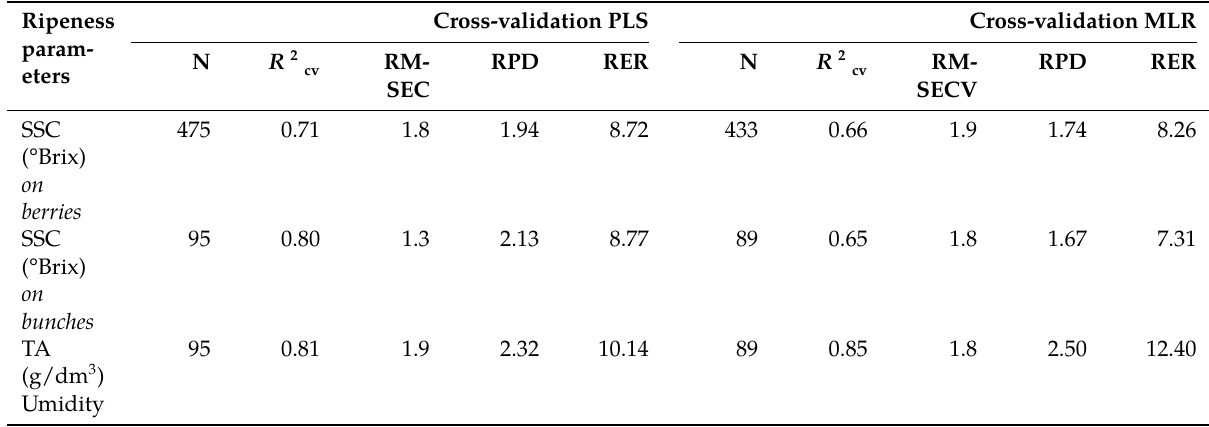
Table 4: Descriptive statistics and statistics of the PLS models elaborated on VIS-NIR spectra and of the MLR models, based on data of the simplified device (four wavelengths 630, 690, 750, and 850 nm) to predict the ripeness parameters of white grapes ( Giovenzana et al.,